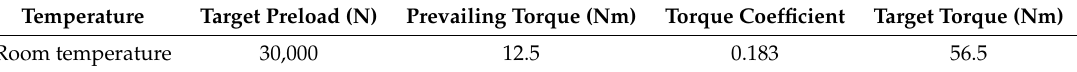
Figure 4. The pre-tightening process of the bolted connections. Table 2. Several parameters related to the pre-tightening process.